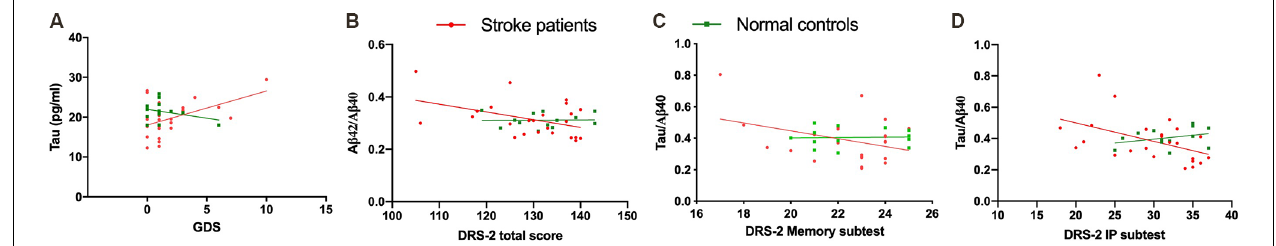
FIGURE 2 | The correlations among cognitive results and plasma biomarkers. Geriatric Depression Score (GDS) vs. tau (A) . Dementia Rating Scale-2 (DRS-2) total score vs. A β 42/A β 40 ratio (B) . DRS-2 memory subtest score vs. tau/A β 40 (C) . DRS-2 initiation and perseveration (DRS IP) subtest score vs. tau/A β 40 (D) .